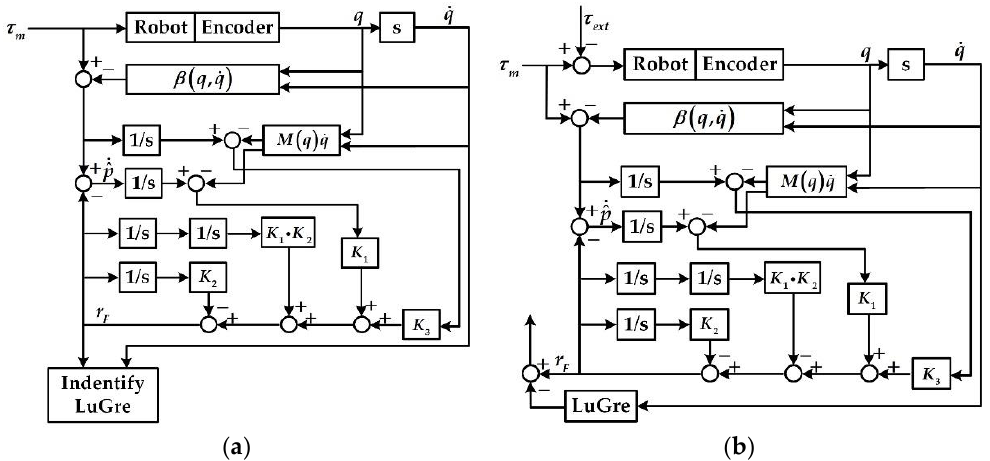
Figure 1. Block diagram of proposed estimation method architecture: ( a ) Identification of the LuGre model; ( b ) Observation of the external torque.